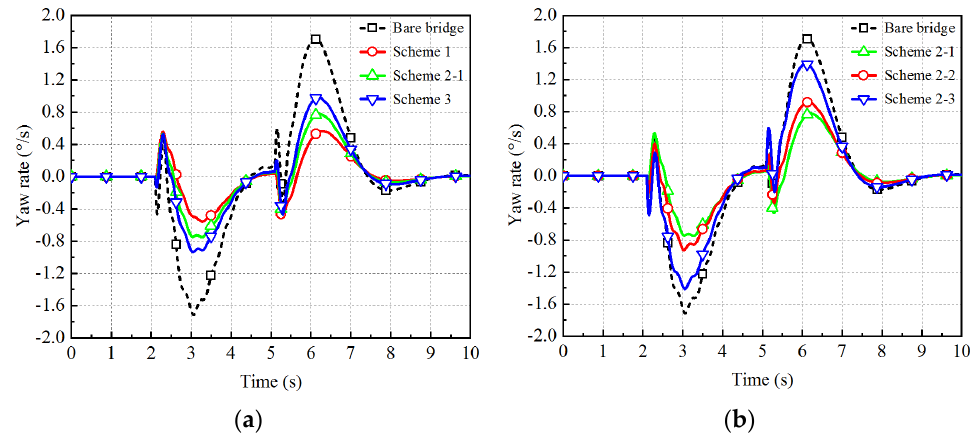
Figure 19. Yaw rate with different bridge wind barriers (( a ) Different porosity scheme; ( b ) Different height scheme).